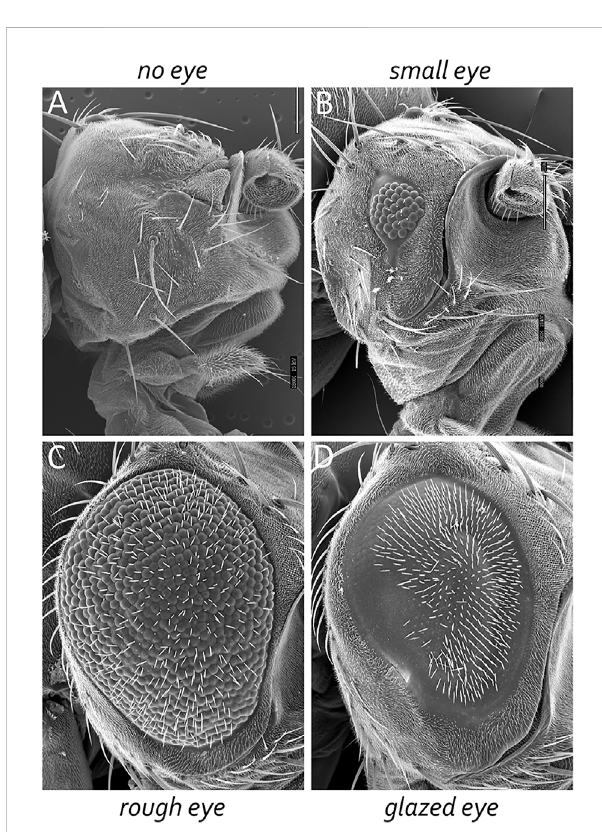
FIGURE 6 The Drosophila compound eye is a model system for identifying genes involved in development. Mutations that affect tissue speci fi cation,growthandproliferation,patternformation,andcellfate speci fi cationcanbeidenti fi edbyalterationsinthecrystalline-like nature of the adult compound eye. These mutant phenotypes can manifest themselves as (A) the absence of eyes, (B) small eyes, (C) large-roughened eyes, and (D) large-glazed looking